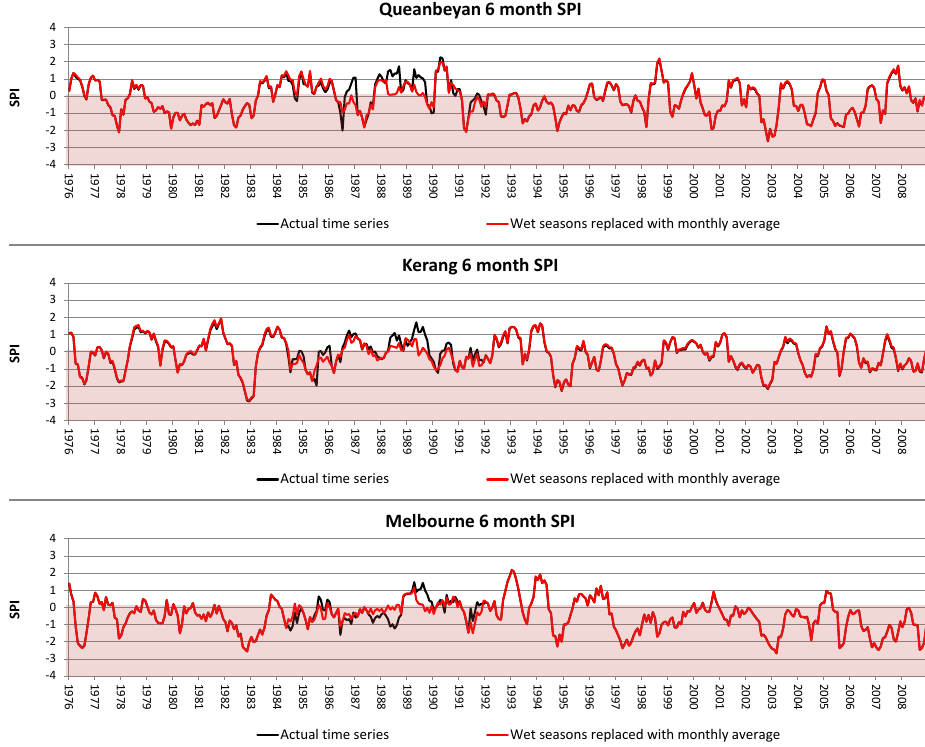
Figure 18. Monthly time series of SPI from 1976 to 2009 at Queanbeyan, Kerang and Melbourne (red shading shows SPI values that indicate dry conditions).